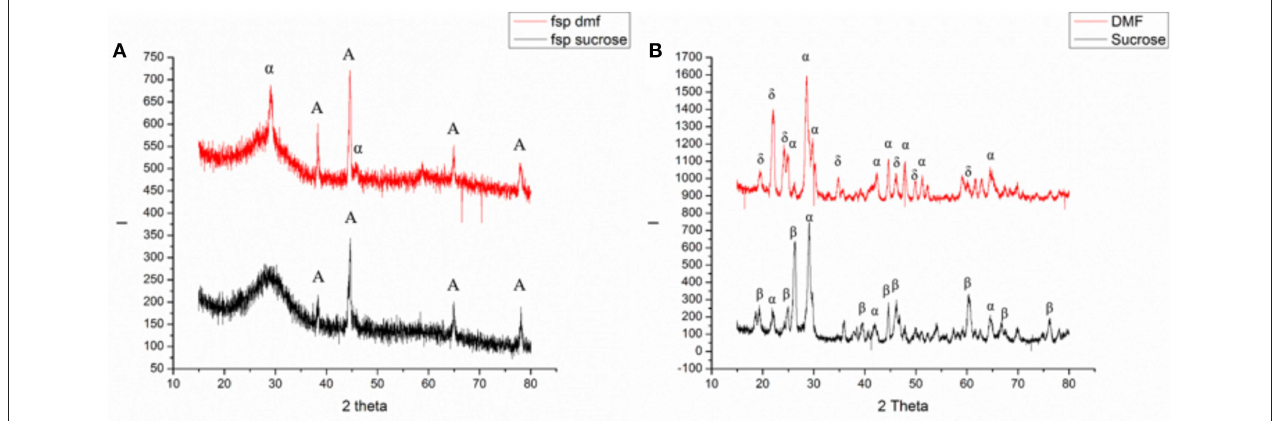
FIGURE 1 | Results of XRD analysis of (A) as-synthesized and (B) calcined powders [A: Ammonium Vanadyl Hydrogen phosphate hydrate (NH